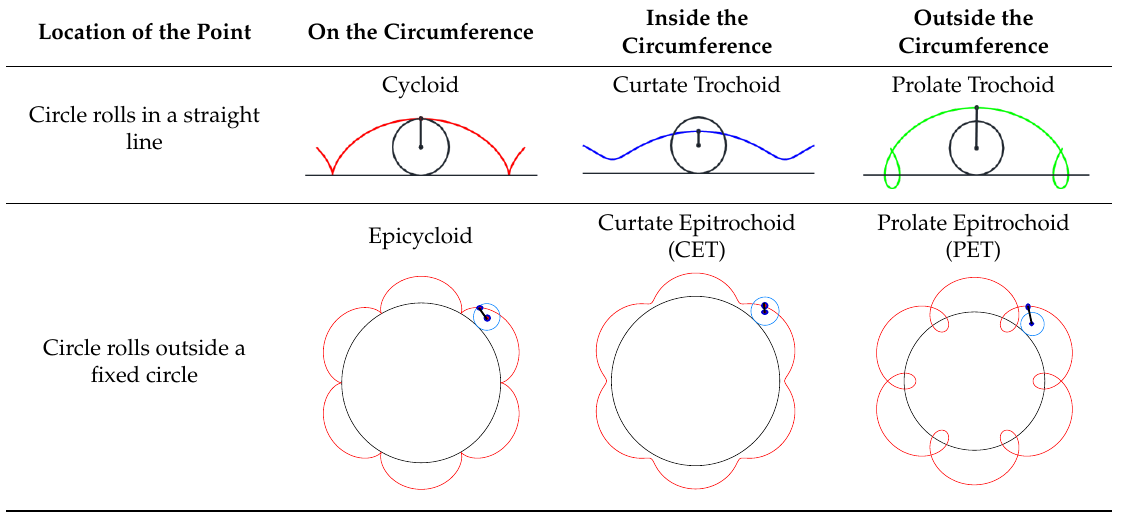
Table 1. Cycloid curve types.